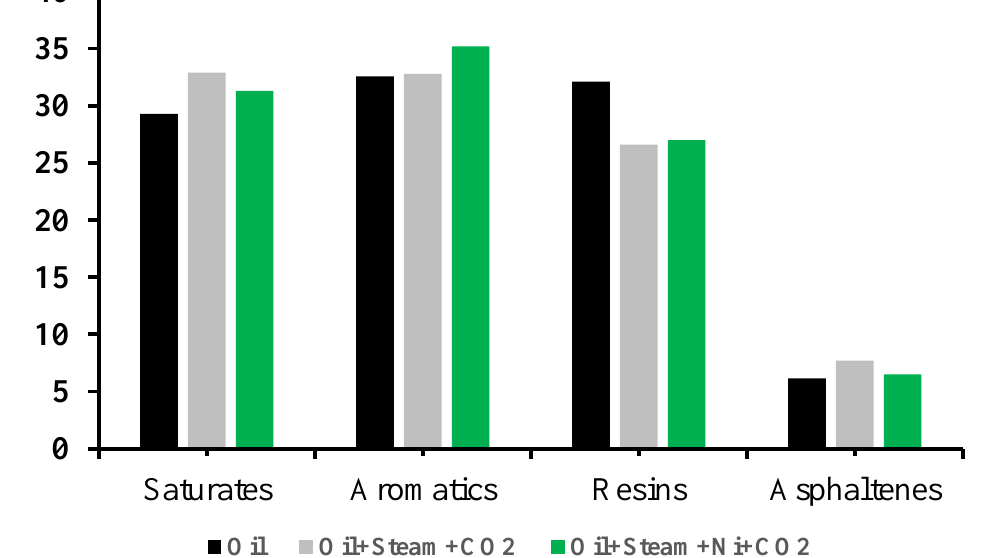
Figure 3. The chemical group composition of oil